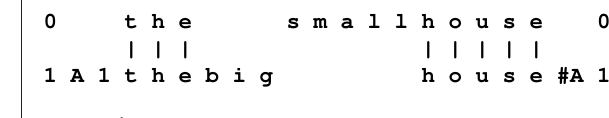
FIGURE 1 | A multiple alignment produced by the SP computer model showing a partial match between a New pattern (in row 0) and an Old pattern (in row